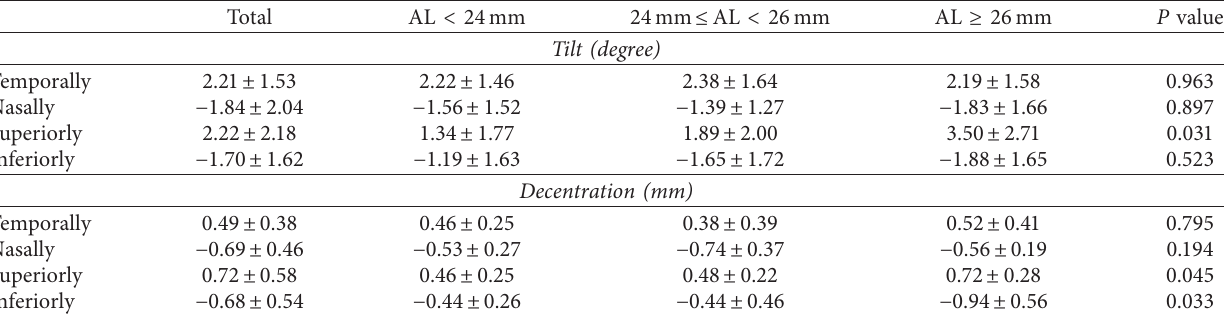
Figure 2: Degree and distribution of IOL tilt and decentration in CEL patients. Table 2: IOL position parameters of CEL patients according to axial length.